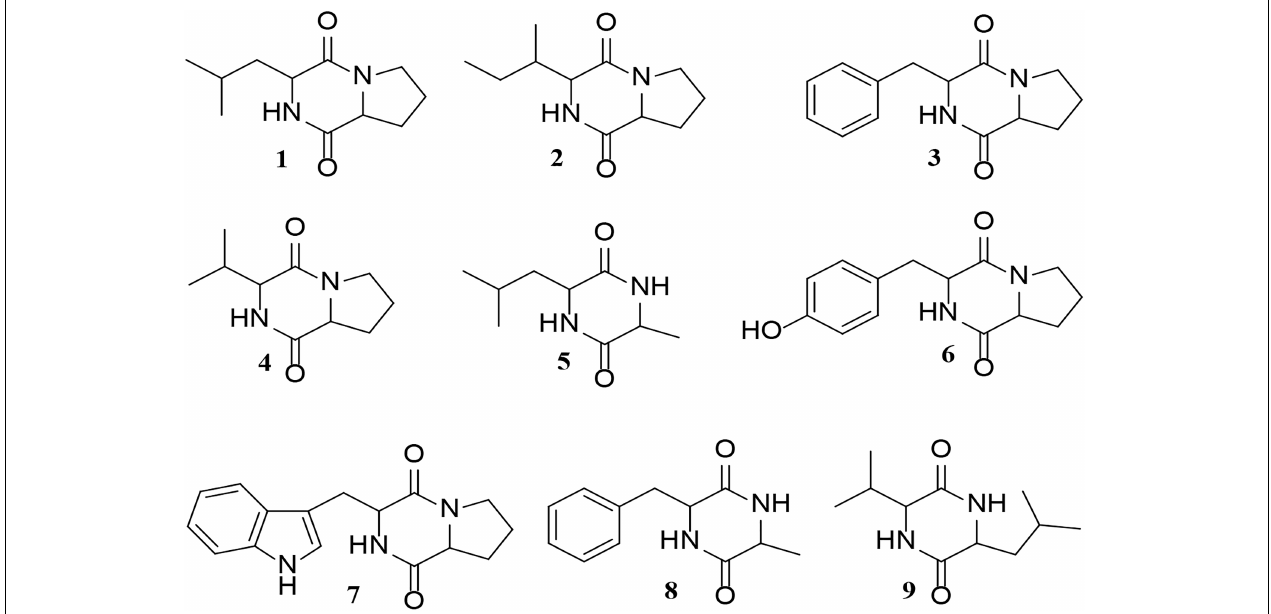
FIGURE 9 | Structure of the putative diketopiperazines identified in the extract of Glycomyces sediminimaris UTMC 2460: 2,5-diketopiperazines cyclo-(leucyl-prolyl) ( 1 ), cyclo-(isoleucyl-prolyl) ( 2 ), cyclo-(phenylalanyl-prolyl) ( 3 ), cyclo-(prolyl-valyl) ( 4 ), cyclo-(alanyl-leucyl) ( 5 ), cyclo-(prolyl-tyrosyl) ( 6 ), and cyclo-(prolyl-tryptophyl) ( 7 ), cyclo-(alanyl-phenylalanyl) ( 8 ), and cyclo-(leucyl-valyl) ( 9 ).